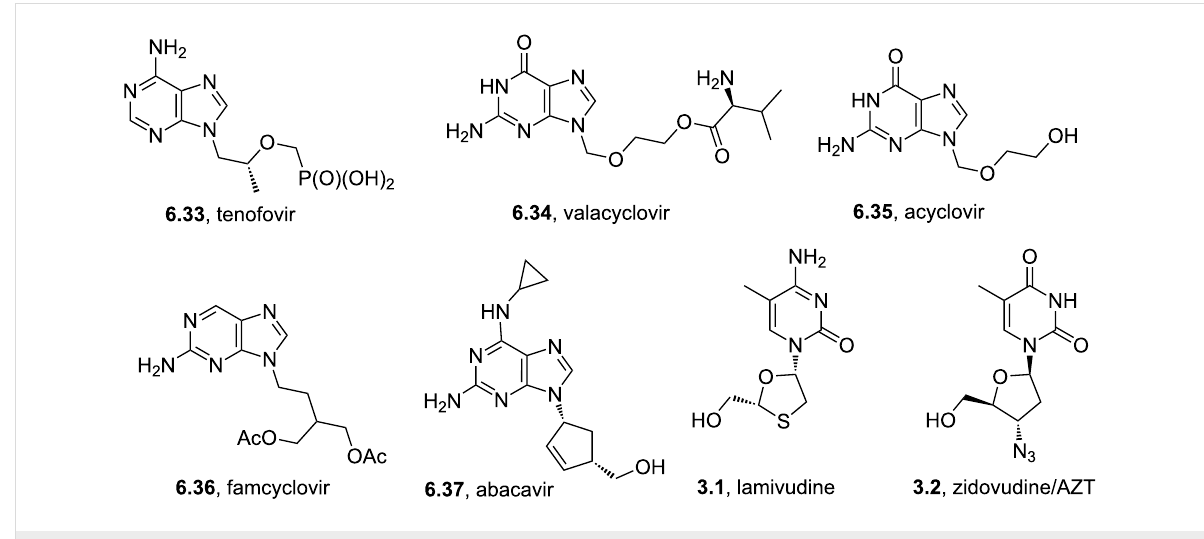
Figure 18: Structures of various anti HIV-medications.